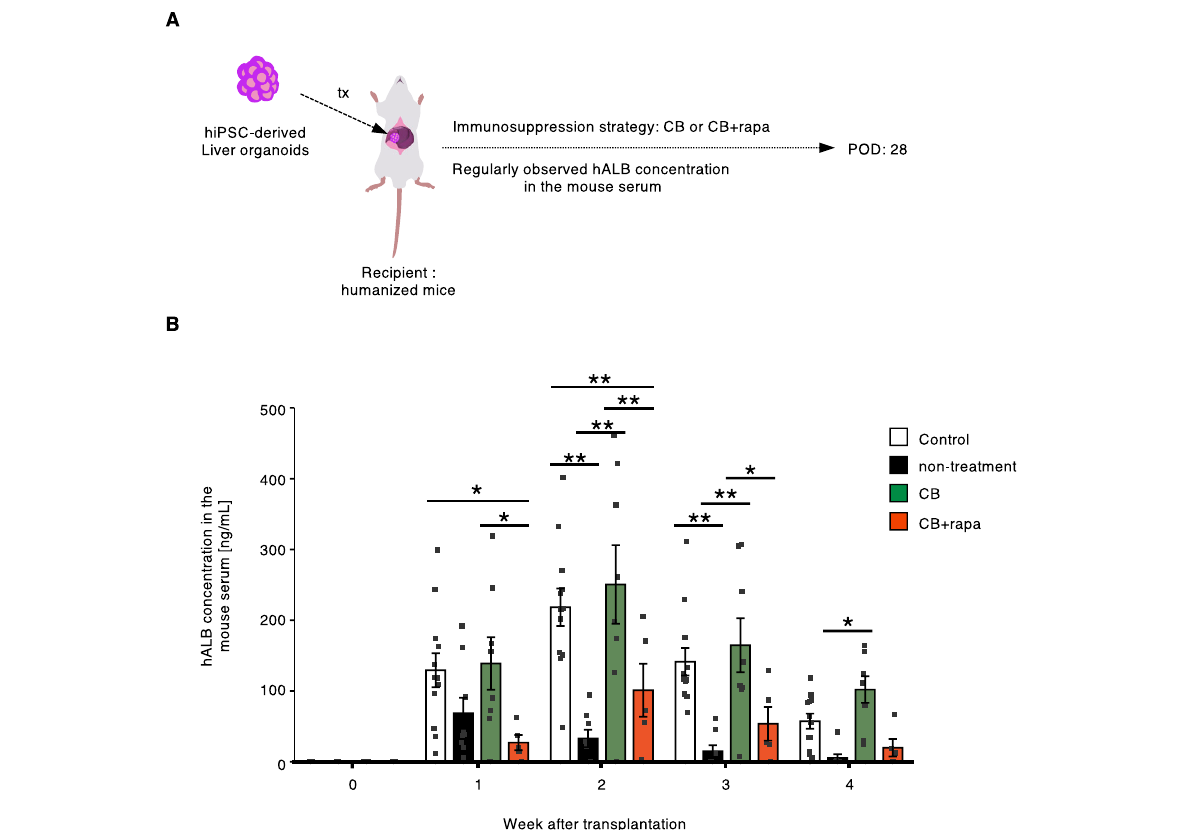
Fig. 4 Co-stimulatory blockade alleviates immune response against human iPSC-derived liver organoids. ( A ) Schematic overview of human iPSC- derived liver organoid transplantation. ( B ) Human albumin concentration in the serum of liver organoid recipient mice ( n = 12, control; n = 8-9, non-treatment; n = 7, CB; n = 5, CB + rapa). * p < 0.05, ** p < 0.01 (two-way repeated measure ANOVA Tukey ’ s multiple comparisons test). hiPSC, human iPSC; tx, transplantation; CB, co-stimulatory molecule blocking; rapa, rapamycin; POD, post-operative day; hALB, human